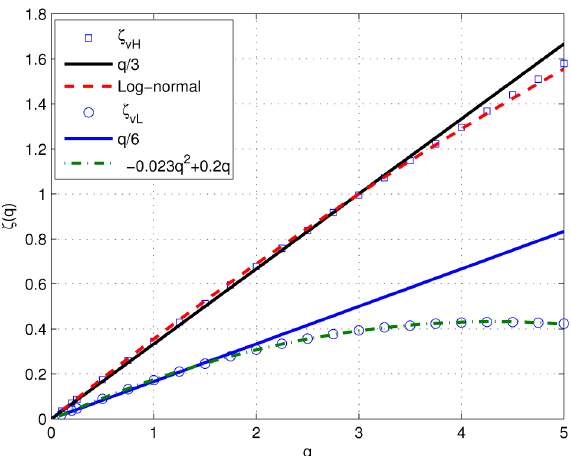
Fig. 5. The empirical scaling exponent function ζ vH ( (cid:3) ) for the inertial range compared to the linear model K41 (solid line) cor- responding to homogeneous turbulence, and the lognormal model (dashed line) taking into account the intermittency effects. The em- pirical scaling exponent function ζ vL ( ◦ ) for the mesoscale range, compared to a linear function ζ vL ( 1 )q ’ q/ 6 (blue solid line) and a quadratic function − 0 . 023 q 2 + 0 . 2 q (green dashed line).